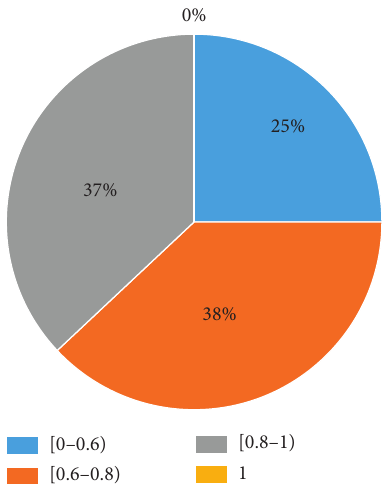
Figure 14: The proportion of coordinated development level u of two